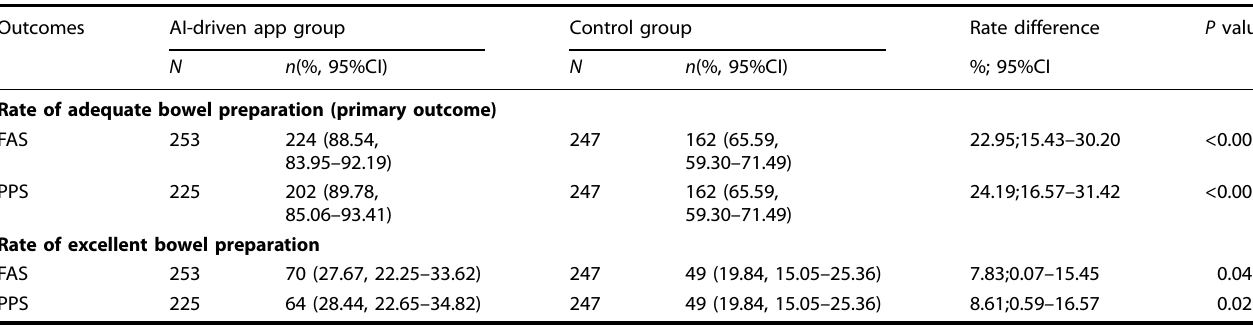
Table 2. The rate of adequate and excellent bowel preparation.